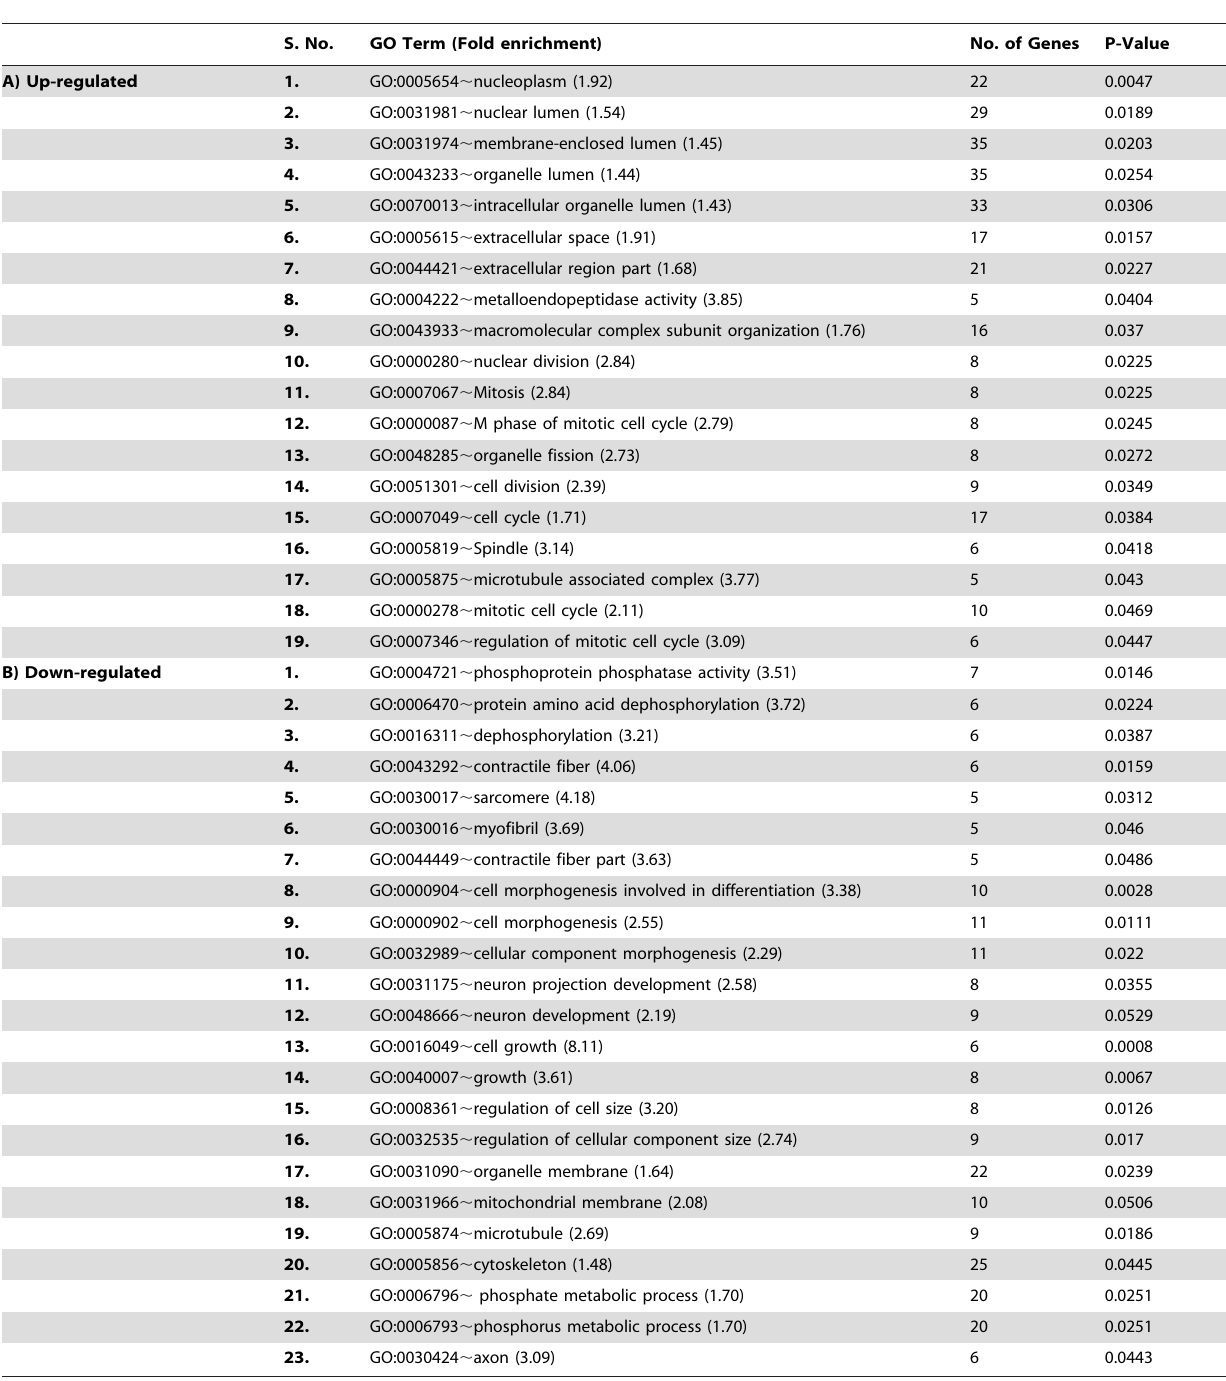
Table 3. Significantly enriched gene ontology terms detected by FAC in A) up-regulated genes, and B) down-regulated genes.